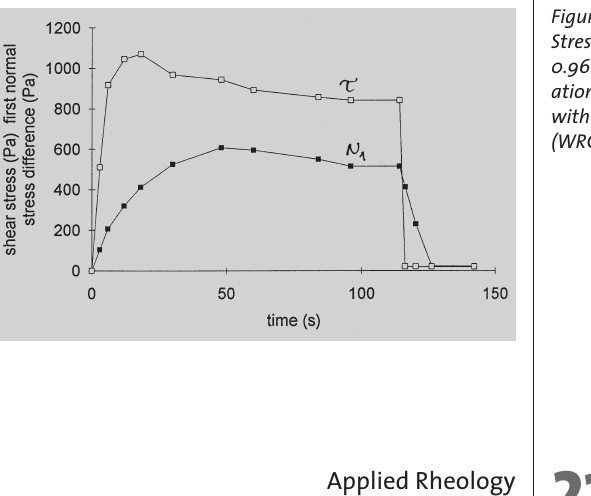
Figure 5: Stressing experiment with 0.96 1/s and stress relax- ation of Araldite GY 260 with 10% Aerosil 380 (WRG, cone-plate 6°,